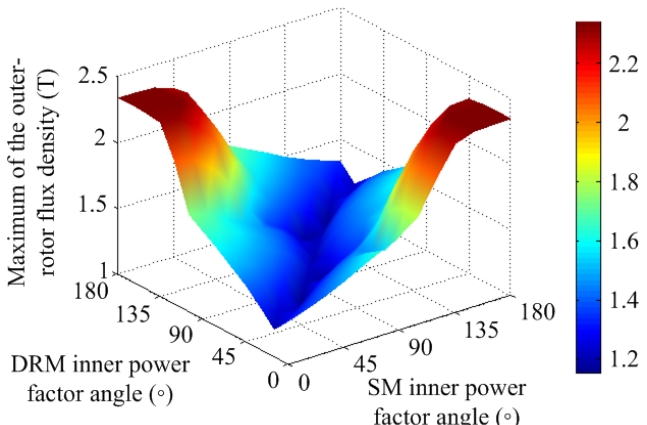
Figure 5. Maximum of the outer-rotor flux density versus the DRM and SM inner power-factor